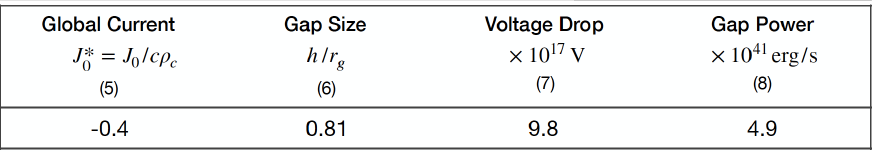
Figure 13. Characteristic gap properties inferred for M87 assuming M BH = 6.5 × 10 9 M (cid:12) and ˙ m = 10 − 5.75 . The columns give the extension or width h of the gap, the associated voltage drop, = − 0.4. Based on ref. and the total gap power for a global current J ∗ 0